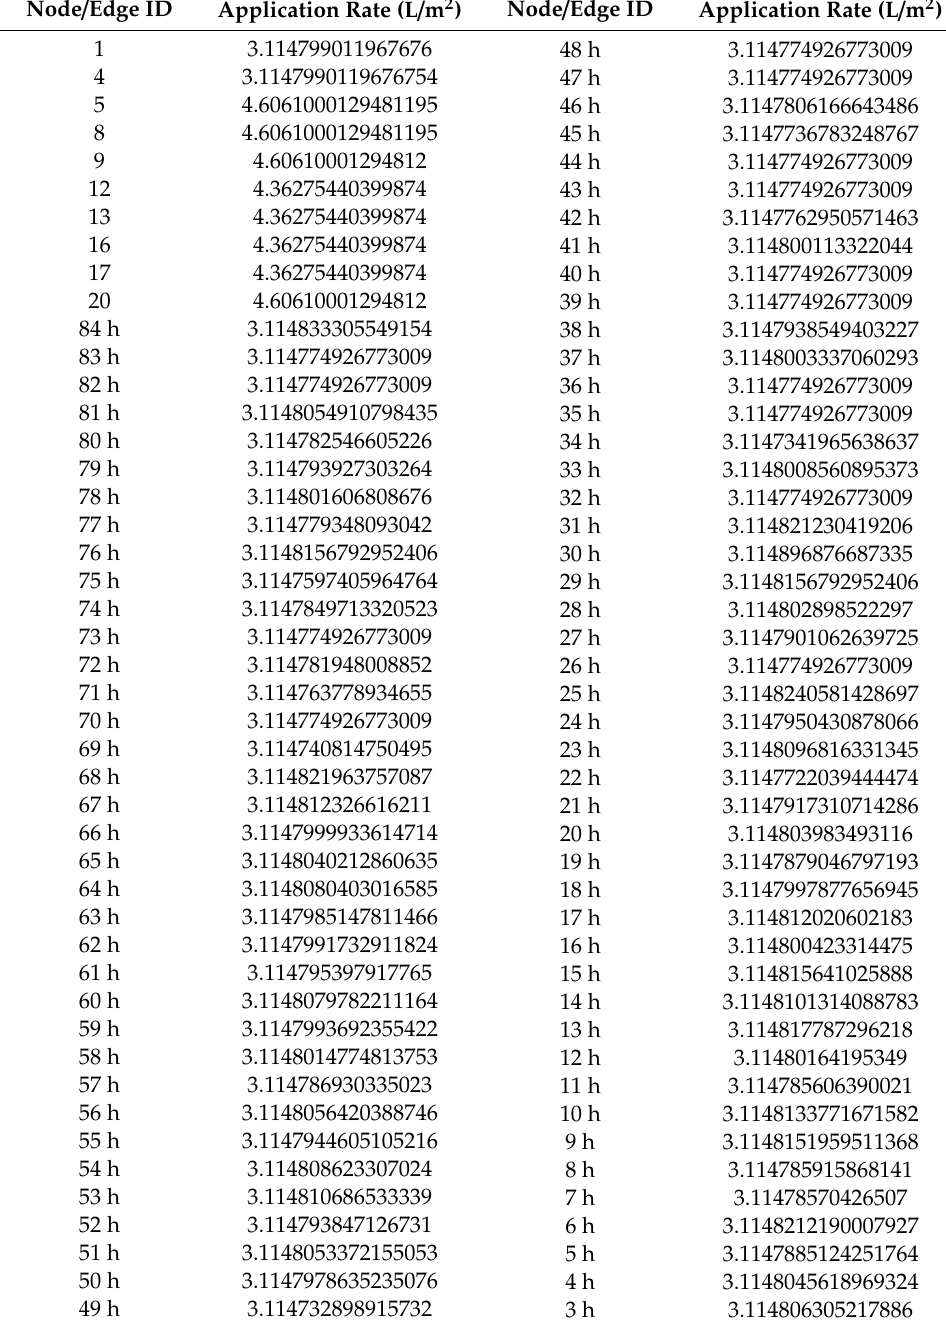
Table A1. List of application rates for case study field-capacity 33 m